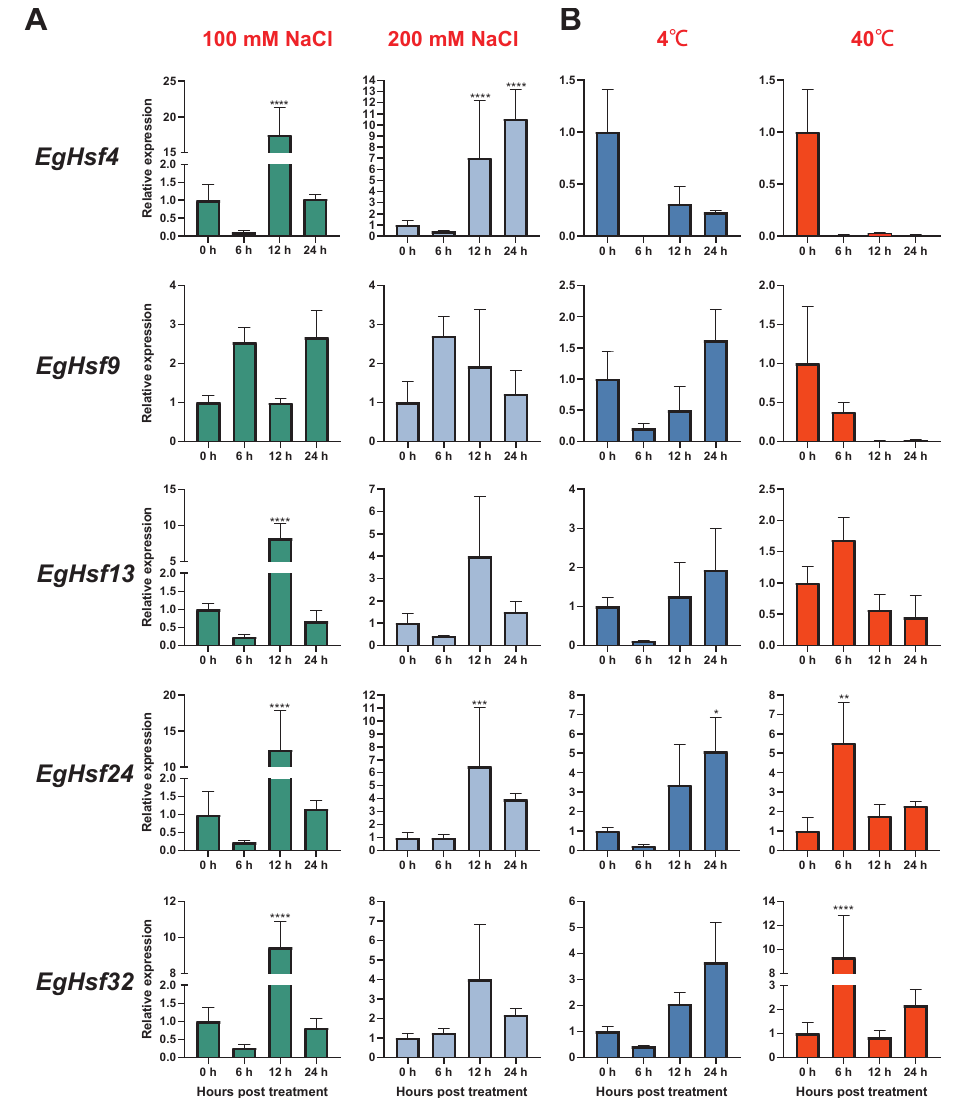
Figure 7. Expression profile of EgHsf genes in eucalyptus responding to salt and temperature stresses tested by qRT-PCR. ( A ) The relative gene expression levels under low salt (100 mL NaCl) and high salt (200 mL NaCl) treatments for the same time periods (0, 6, 12, 24 h). Control seedlings were treated with distilled water. ( B ) Relative gene expression levels under low temperature (4 ◦ C), high temperature (40 ◦ C) and control (25 ◦ C). (* p < 0.05, ** p < 0.01, *** p < 0.0005, **** p <